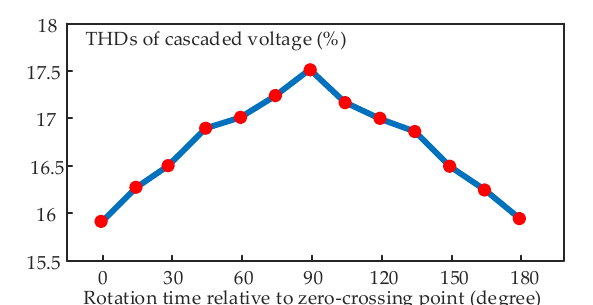
Figure 13. The THDs of the cascaded output voltage with different asynchronous rotation time and carrier ratio K = 4.